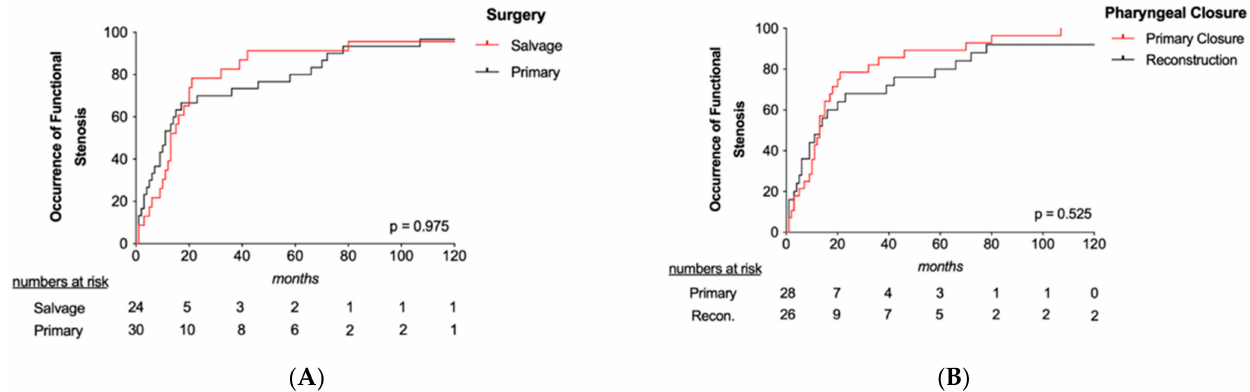
Figure 4. Occurrence of stenosis. Kaplan–Meier plots illustrate that the occurrence of stenosis was not influenced by surgery ( A ) or type of pharyngeal reconstruction ( B